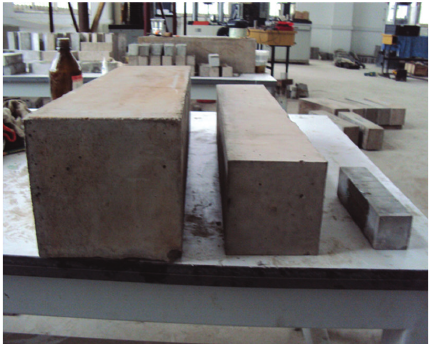
Figure 1: Concrete specimens with beam depths of 40, 100, and 150